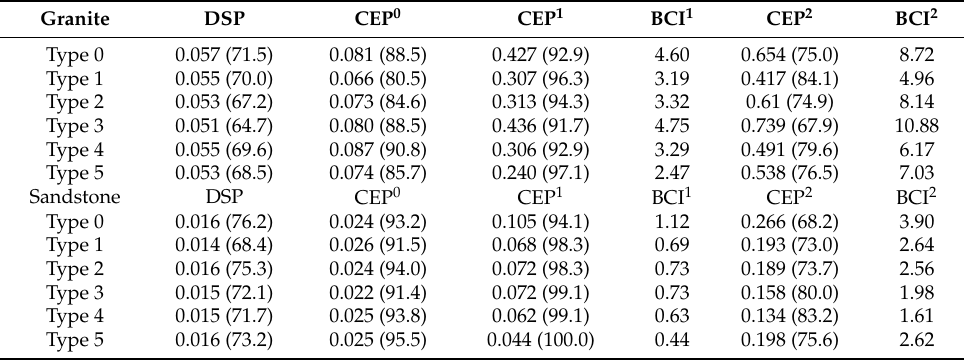
Table 3. Coordinates of CEPs and their